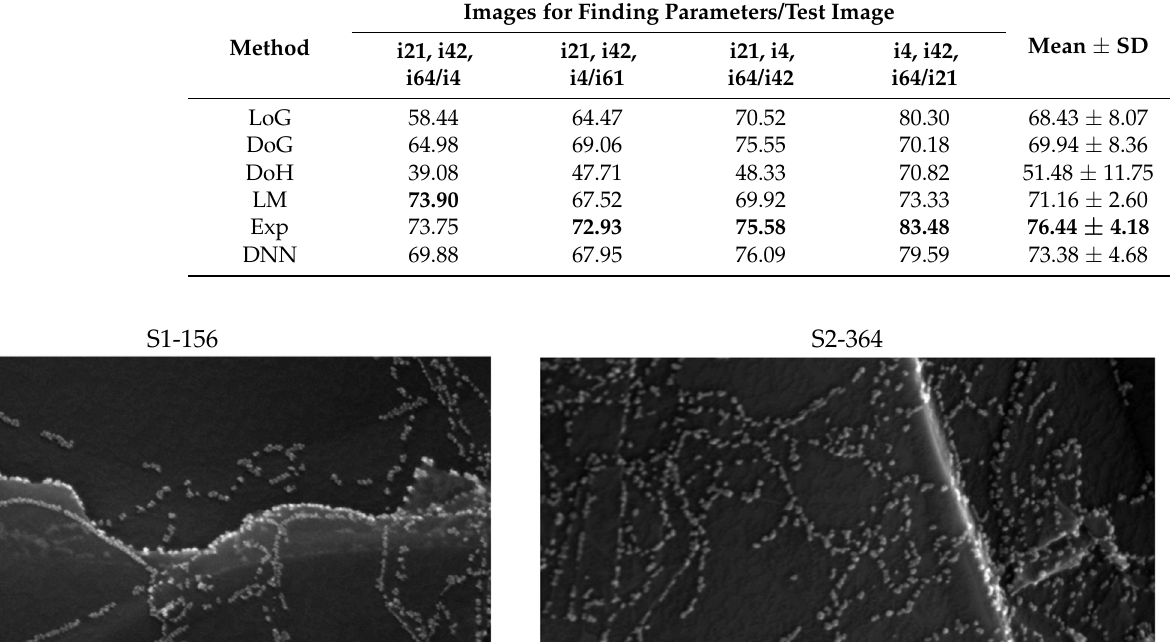
Table 2. Accuracies of nanoparticle detection for parameters estimation based on the leave-one-out procedure.